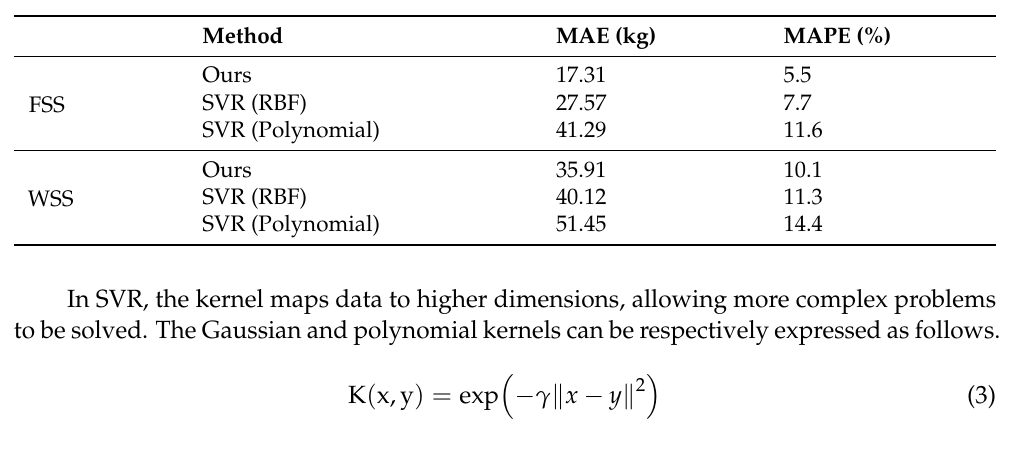
Table 4. Weight estimation performance of FSS and